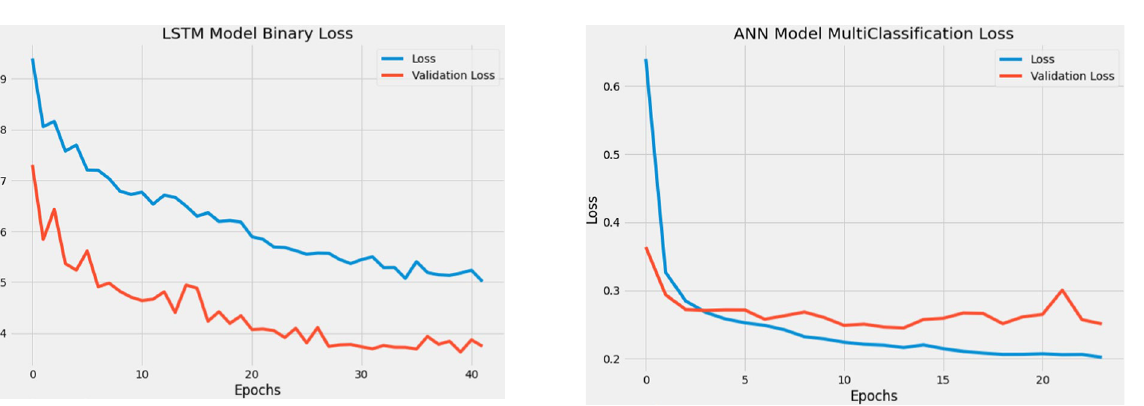
Fig. 12 Training and validation loss of